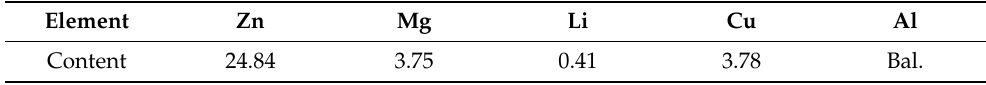
Table 1. Actual chemical composition of the studied alloy (wt.%).